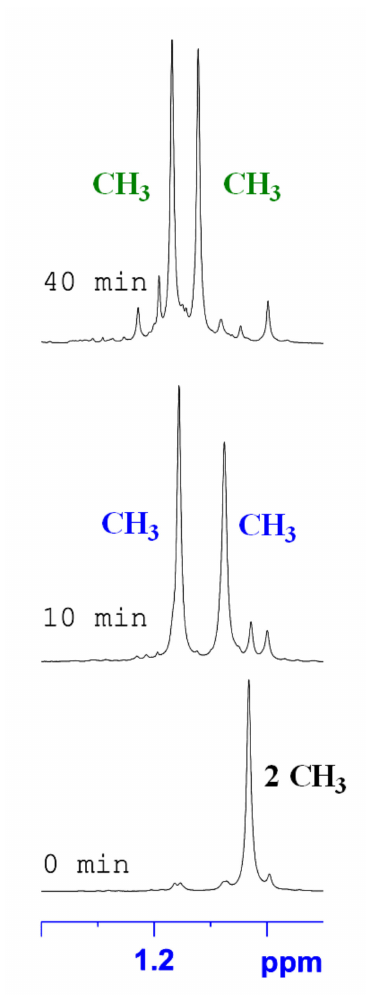
Figure 4. Monitoring of the rearrangement process at 150 ◦ C by 1 H-NMR (for compound 1b